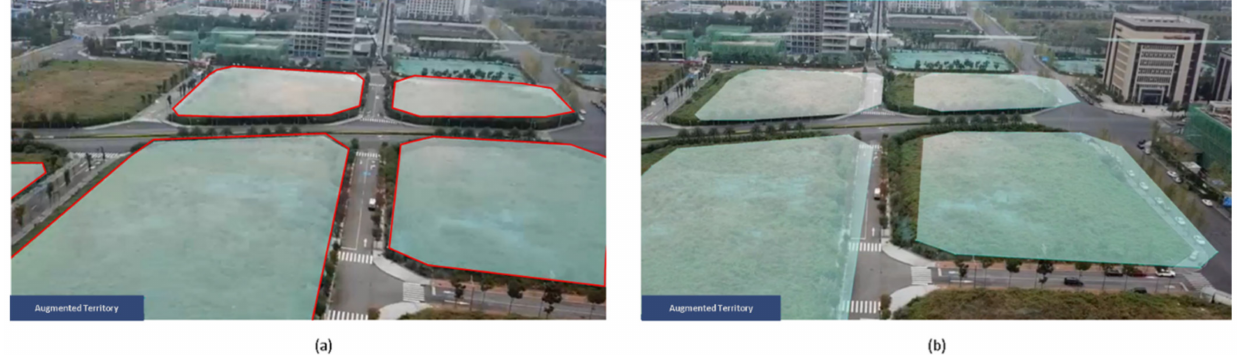
Figure 11. Two methods of vector data visualization for AT: ( a ) our method, ( b ) sensor-based